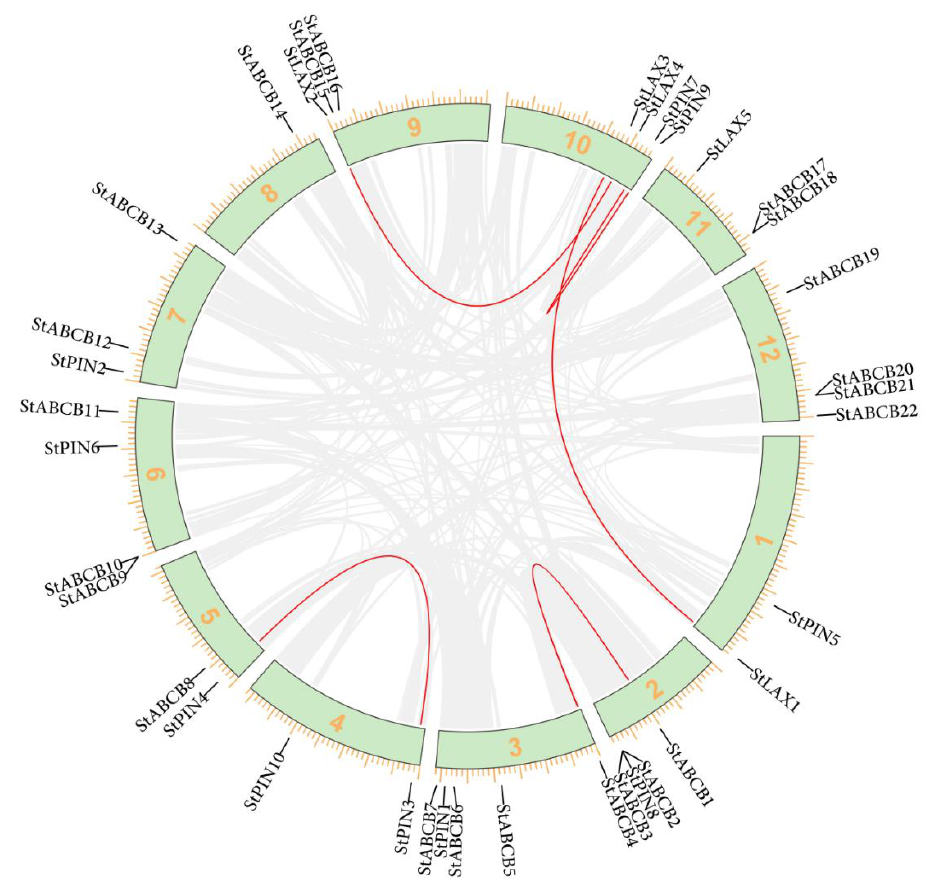
Figure 1. Chromosomal distribution of StLAX, StPIN, and StABCB family genes. Potato chromosomes are arranged in a circle. Five StLAX genes, 10 StPIN genes, and 22 StABCB genes are mapped by locus, and the duplicated gene clusters are represented by red lines.